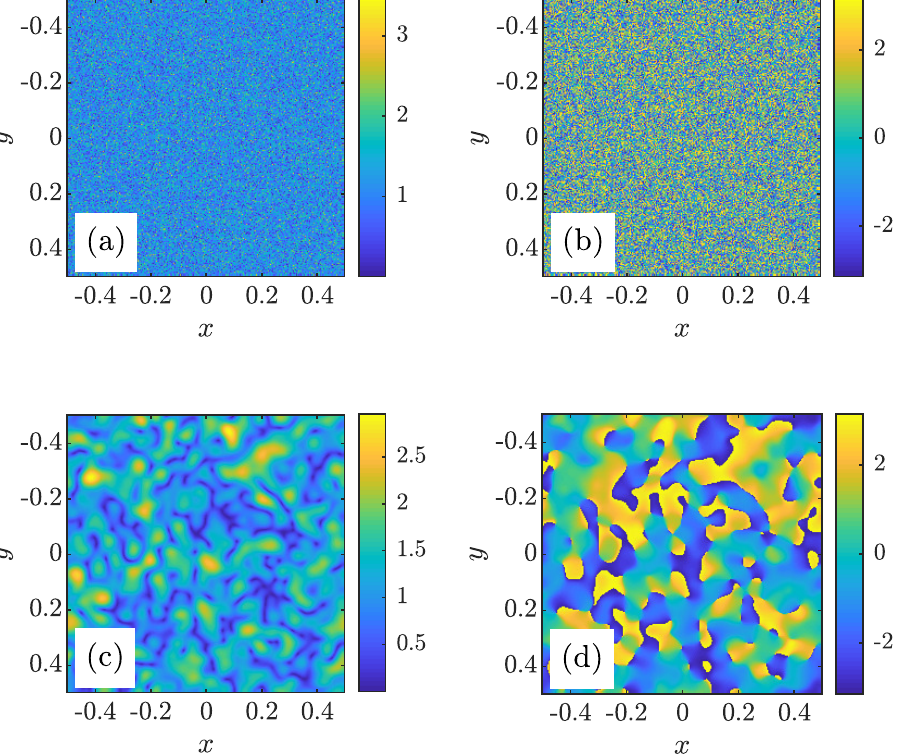
Figure 4. Rejection sampling (RS) and normal to anything (NORTA) E x realizations: ( a ) RS | E x | , ( b ) RS arg ( E x ) , ( c ) NORTA | E x | , and ( d ) NORTA arg ( E x )